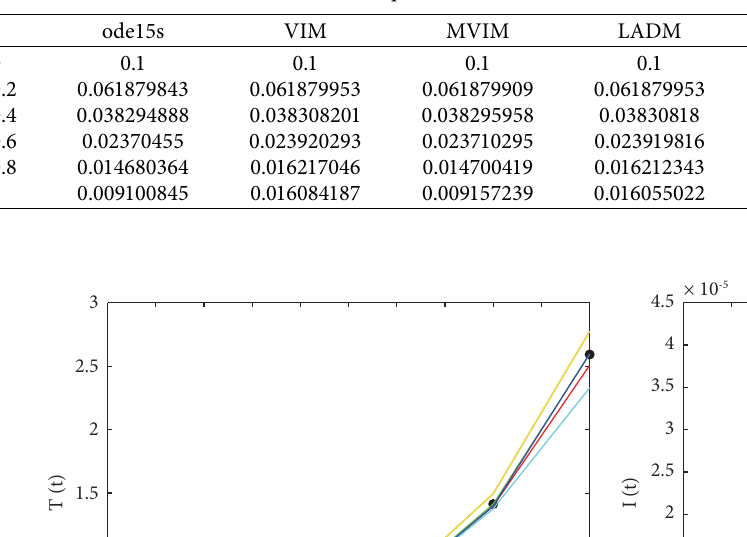
Table 3: Numerical comparison for values of V ( t ) , ω � 0 . 57, and θ � 1 using diferent